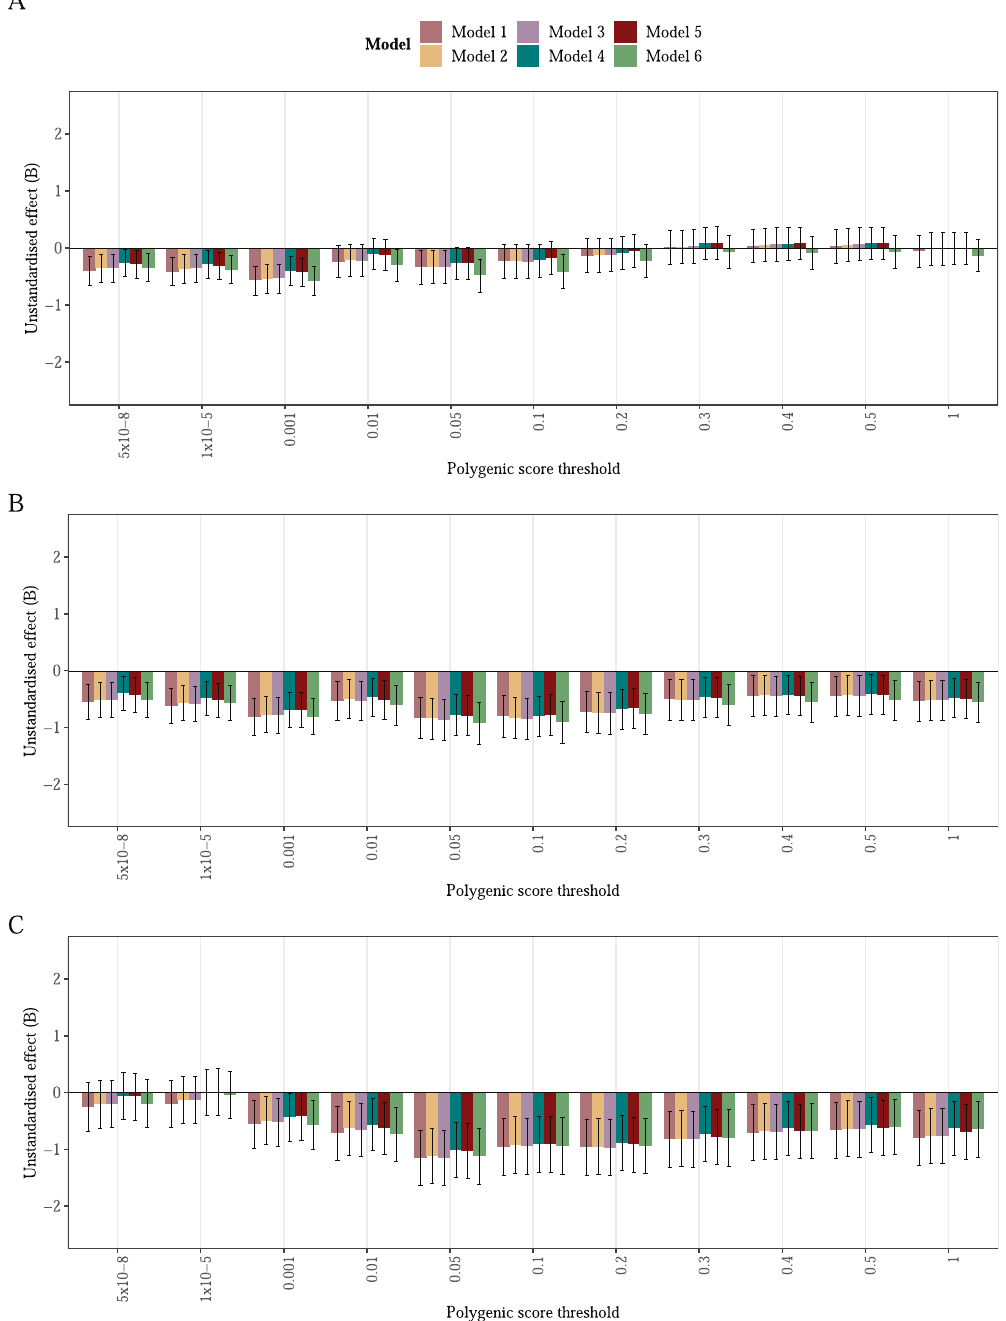
Fig. 2 Schizophrenia polygenic score (PGS) associated with disorder severity measured as Clinical Impairment Assessment (CIA) total score. Bars represent beta estimates ± standard errors. A is based on 2843 individuals with anorexia nervosa and additional eating disorder diagnoses during their lifetime. B is based on 1839 individuals with any clinically ascertained anorexia nervosa diagnosis. C is based on 976 individuals with a clinically ascertained anorexia nervosa restricting subtype. The estimates in model 4 are adjusted for covariates included in the main model: Principal components 1 – 10, treatment region, age, sex, follow-up time and eating disorder diagnosis when including individuals with any eating disorder diagnosis ( n = 2843). the BMI PGS and severity is consistent with fi ndings that patients with high SCZ PGS represent a distinct phenotype with associated genetic liability to high BMI with engaging in more different treatment needs and response. weight loss behaviours [59] and higher levels of disordered eating In our study, patients with AN carrying a greater BMI PGS [60] in the general population. These studies [59, 60] and our experienced greater severity compared to eating disorder patients fi nding support a shared genetic aetiology between genetic with low BMI PGSs. This fi nding stands in contrast to negative propensity for high BMI and eating disorder severity or speci fi c genetic correlation between BMI and AN as a diagnosis based on symptoms. As fear of weight gain, a central symptom among GWAS data [27, 55, 58]. However, the positive association between Translational Psychiatry (2022)